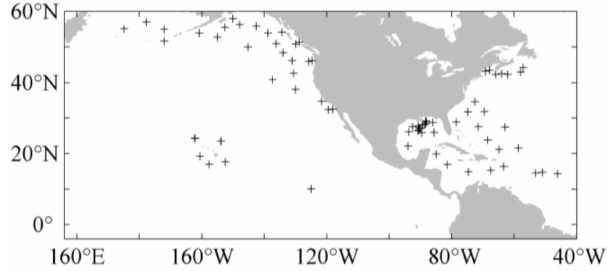
Figure 1. Locations of the National Data Buoy Center (NDBC) buoys (black plus) used in the present